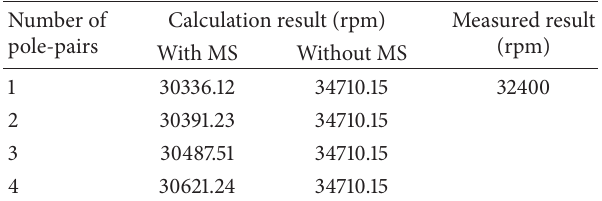
Table 1: Parameters of DX100A-24000/20-type motorized spindle.